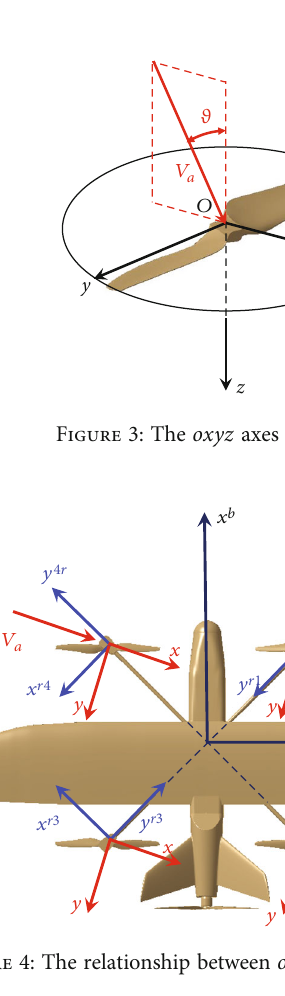
Figure 1: The systems of axes used in